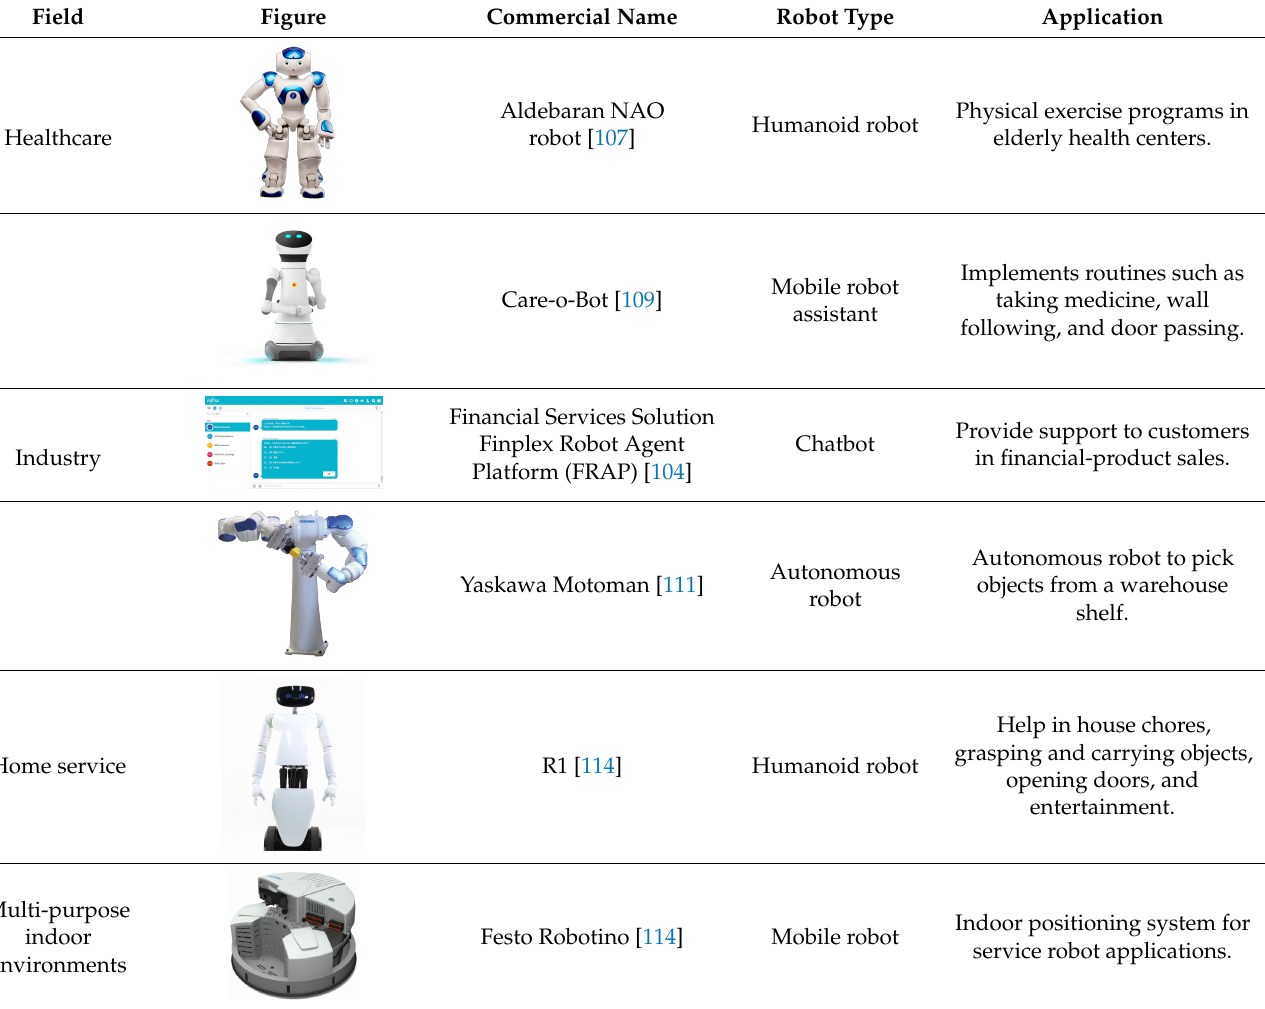
Table 3. Service robots’ current